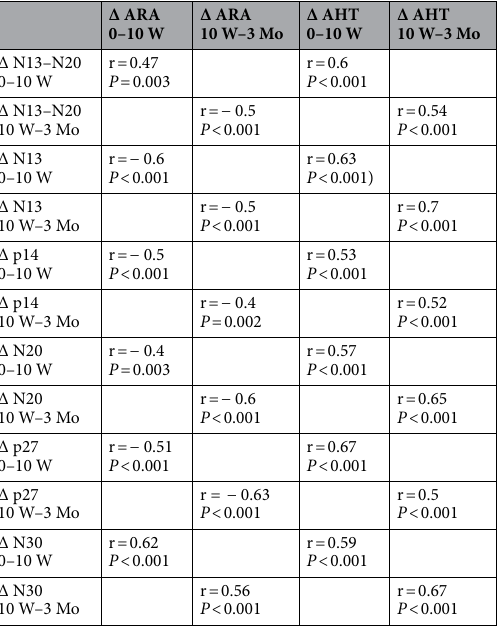
Table 4. Pearson correlation (r) matrix between variables for the intervention group. Anterior head translation (AHT), cervical lordosis absolute rotation angle (ARA) C2–C7, Δ = change in the variable over time shown. Δ 0 – 10 W: the amount of change between initial base line and 10-weeks of treatment. Δ 10 W – 3 Mo: the amount of change between the 10-weeks of treatment values and 3-month follow-up.